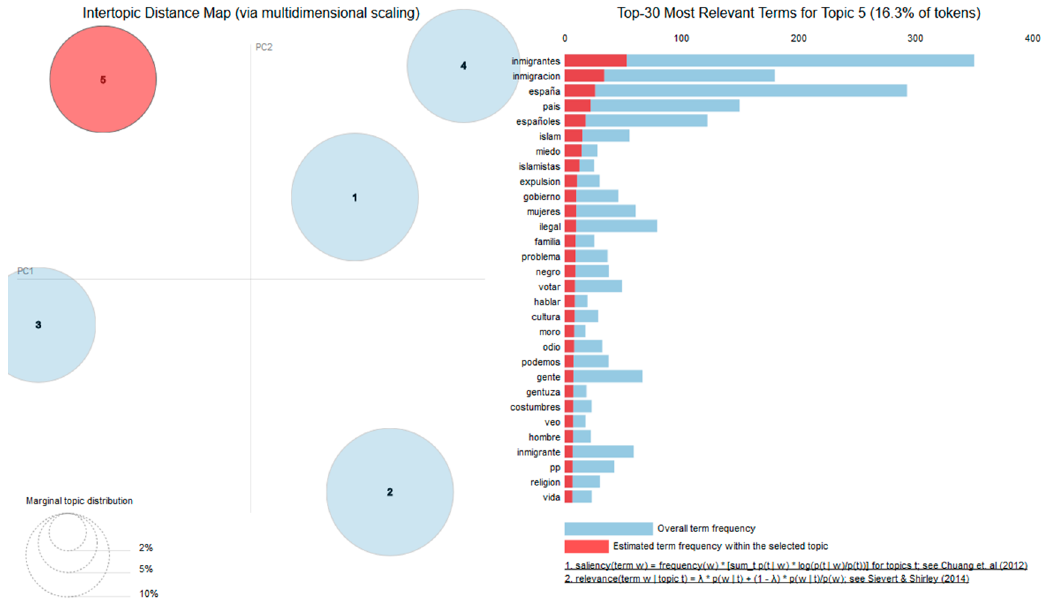
Figure 8. Interactive map of topic 5, ƛ = 1.